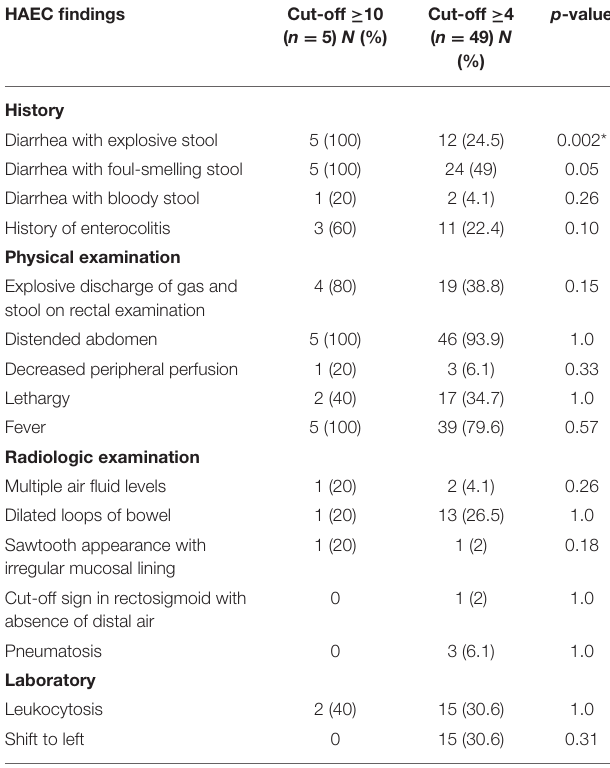
TABLE 1 | Baseline characteristics of HSCR patients treated with TEPT procedure in our institution. Characteristics